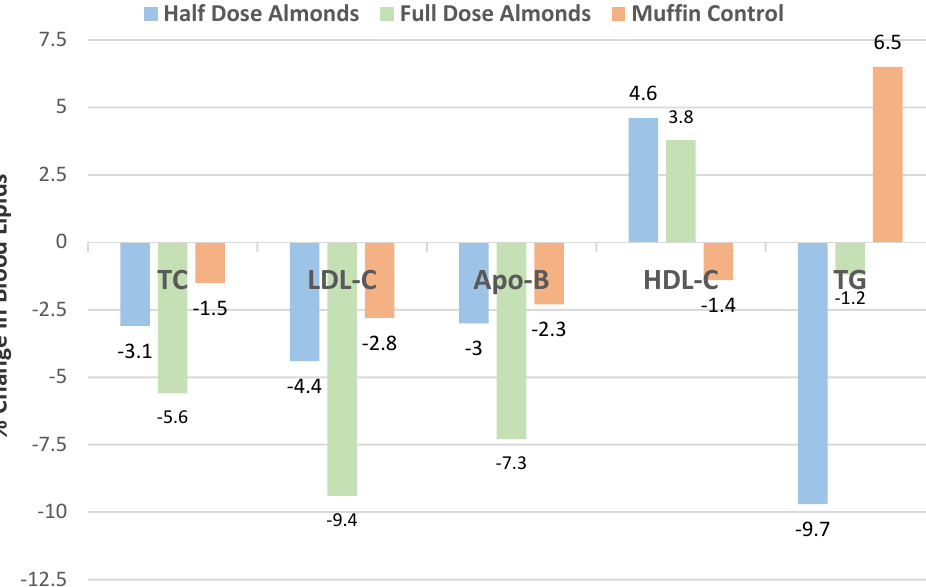
Figure 29. Dose–response effects of almond-enriched NCEP Step 2 diets from baseline to 4 weeks: (1) full-dose almonds significantly reduced TC, LDL-C, and Apo-B ( p < 0.001), (2) half-dose almonds reduced TC, LDL-C, and Apo-B ( p < 0.057), (3) both almond doses significantly increased HDL-C ( p < 0.047), and (4) the muffin control only significantly increased triglycerides ( p = 0.031), with no significant changes in non-HDL or HDL-C blood lipids [51].